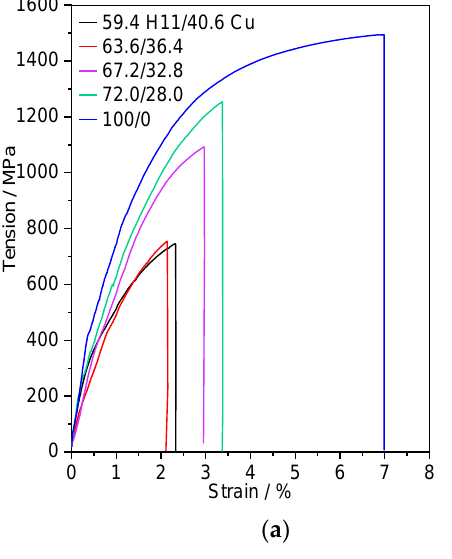
Figure 9 . ( a ) Stress-strain curves and ( b ) tensile strength of the H11/Cu composite materials obtained by infiltration and the sintered H11 tool steel as a function of H11 content.